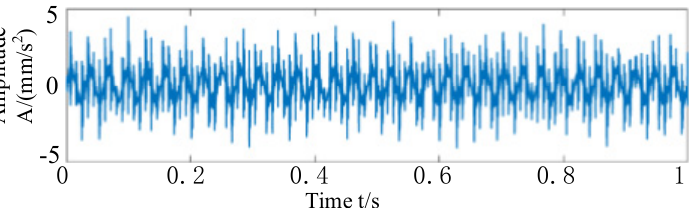
Figure 15. Time-domain waveform diagram of the noise-added vibration signal of the outer ring damage of the rolling bearing.